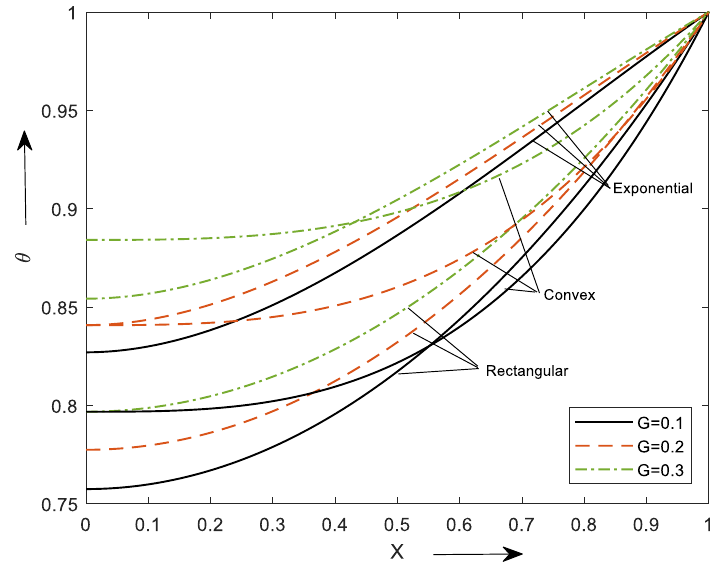
Figure 5. Temperature distribution of different profiles for diverse values of G . The radiative parameter impact (Nr) is shown in Figure 6. With an increment in the radiation number, the thermal profile θ decreases steadily. The lower temperature inside the fin indicates a loss of ambient fluid temperature with radiative parameters.